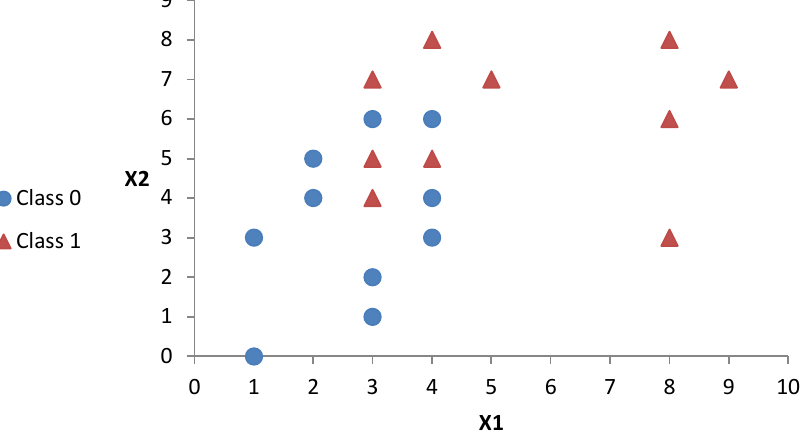
Figure 1. A visual illustration of the synthesized dataset obtained from Table 1.